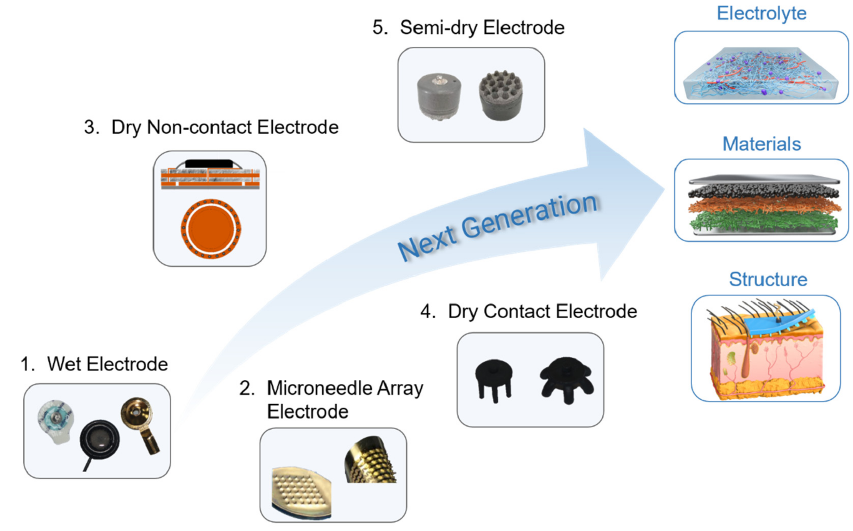
Figure 5. Existing and future trends electrodes.